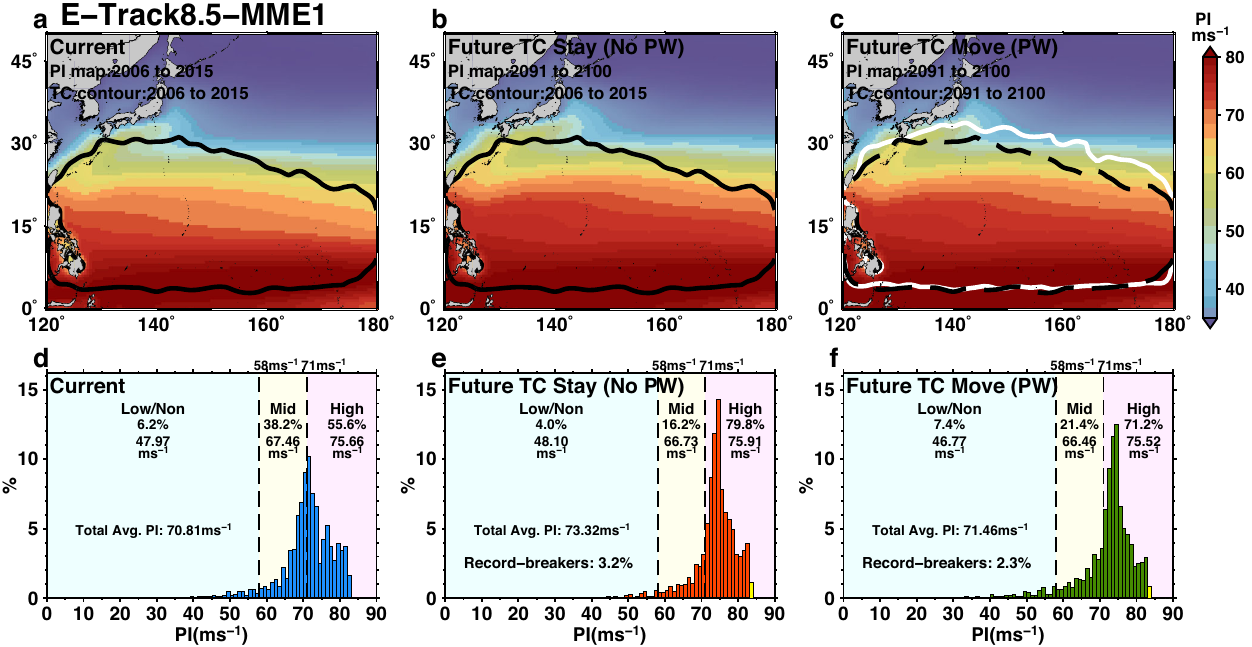
Fig. 5 PI distribution and poleward migration. Comparison between current ( a ) and the 2 future PI scenarios ( b , c ), based on E-Track-8.5 MME1. The background map in colour is the TC-Season averaged PI map. TC location contour, based on intensi fi cation-track points, is overlaid. These points are fi rst interpolated to 2 by 2 grid before contouring, 95% of points are enclosed. a Current: present-day PI map with present- day TC location contour overlaid. b Future TC_Stay: future PI map with present-day TC location contour (in black) overlaid. This contour is the same as in ( a ), because there is no TC movement involved. c Future TC_Move: future PI map with future TC location contour (in white) overlaid. The contour in ( b ) is also shown in dashed black, for comparison. d – f PI probability distribution histogram for Current ( d ), future TC_Stay ( e ), and future TC_Move ( f ). Additional discussions see Supplementary Note